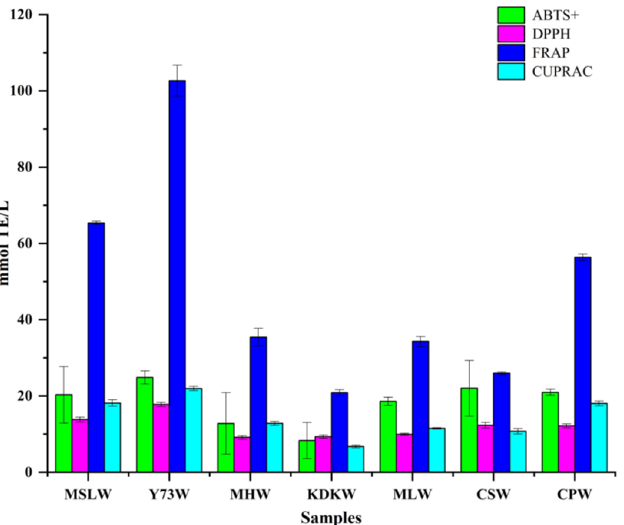
Figure 5. The antioxidant activities (mmol TE/L) of wines produced from seven different grape va ‐ rieties ( p ≤ 0.05). Samples’ full names, as follows: MSL (Marselan), Y73 (Yan 73), MH (Muscat Ham ‐ burg), KDK (Kadarka), ML (Merlot), CS (Cabernet Sauvignon) and CP (Crimpose). Furthermore, G represents “grape” and W represents “wine”.